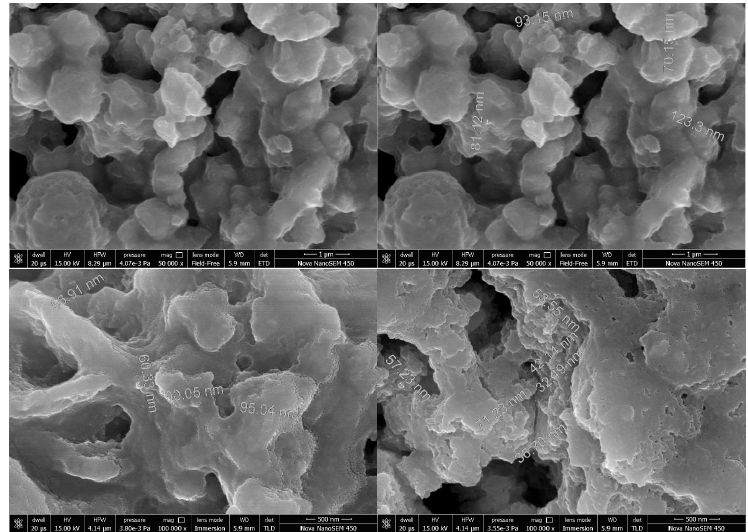
Fig. 4. FESEM images showing the morphology and size of Figure 4: FESEM images showing the morphology and size of Fe-NPs